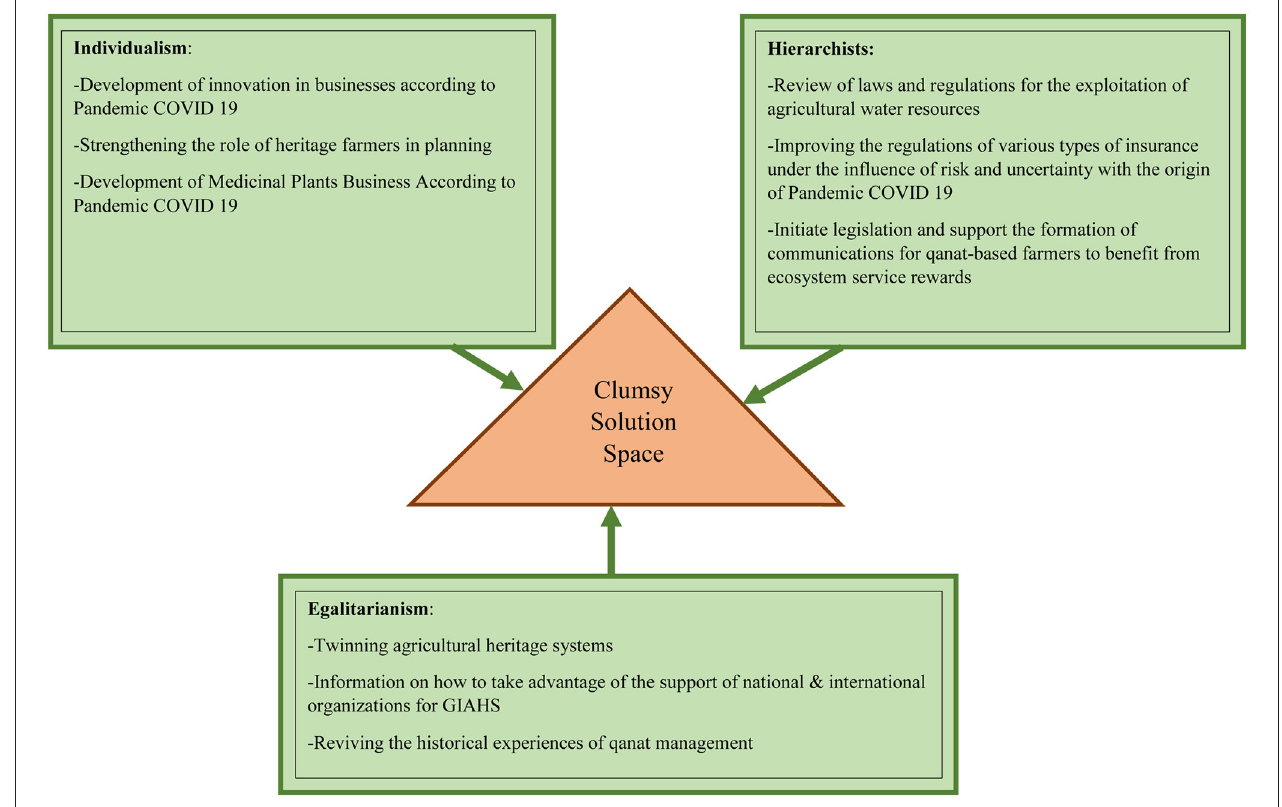
FIGURE 7 | Clumsy solutions